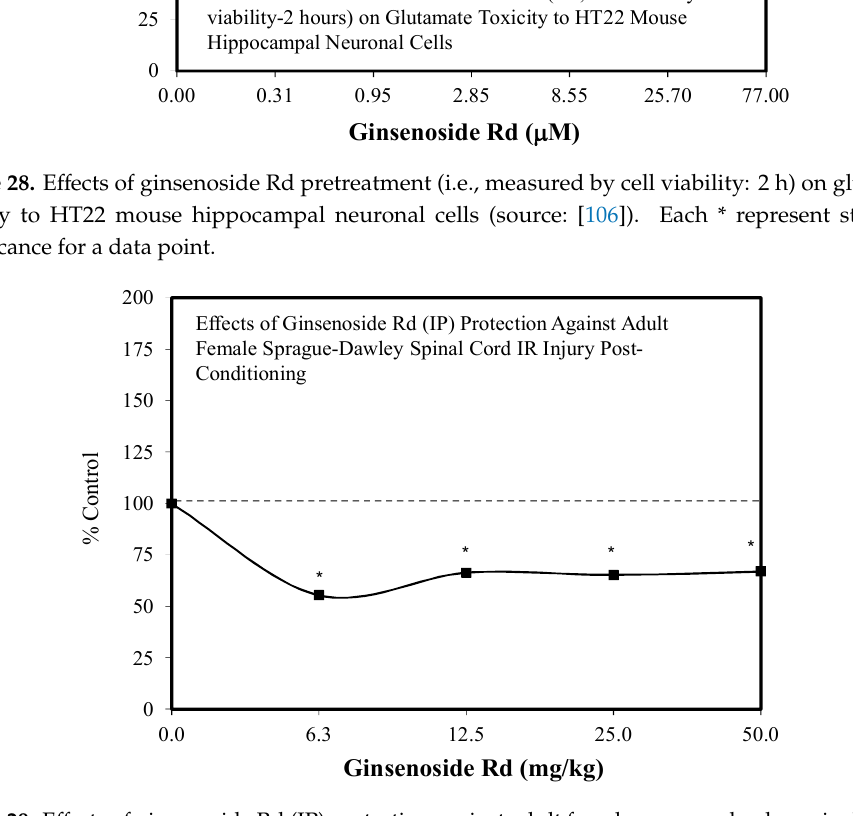
Figure 29. Effects of ginsenoside Rd (IP) protection against adult female sprague-dawley spinal cord IR injury post-conditioning (Source: [107]). Each * represent statistical significance for a data point.